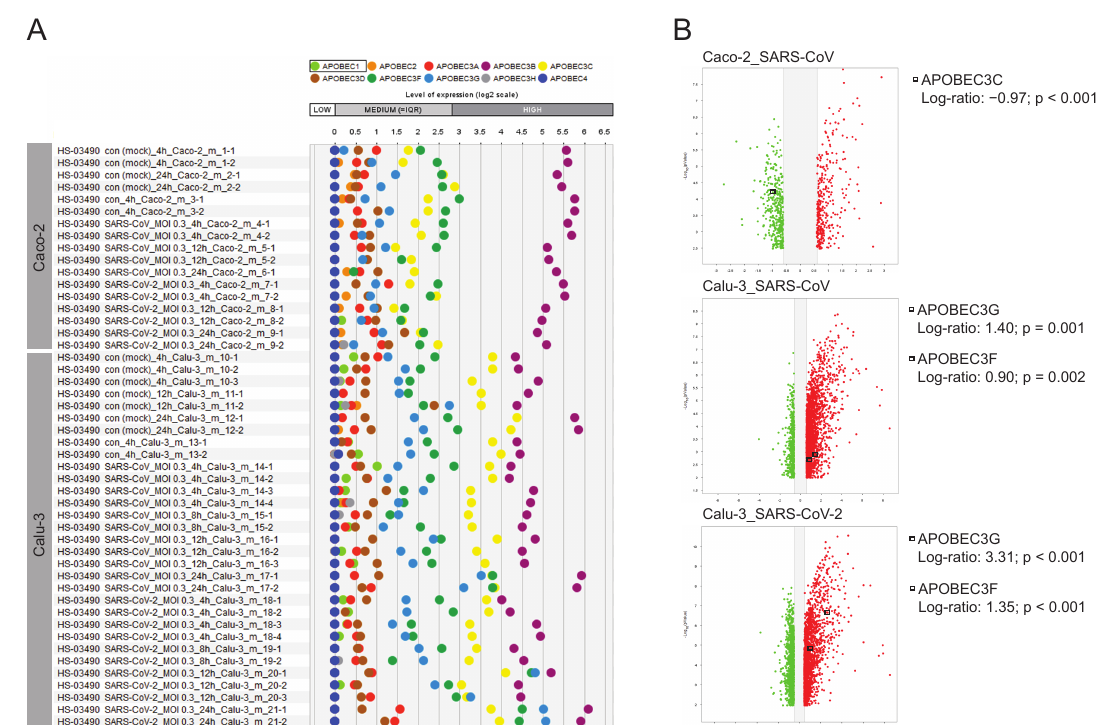
Figure 7. Expression map of APOBECs in Caco-2 cells and Calu-3 cells and their regulation on the transcriptional level upon infection with SARS-CoV-2 or SARS-CoV. Here the GENEVESTIGATOR- based analysis strategy is applied with the focus given to a particular gene set, the APOBECs. ( A ) The expression pattern of 10 APOBECs across the individual conditions is shown by scatterplots on the basis of GENEVESTIGATOR analysis of the mRNAseq dataset GSE148729 across Caco-2 and Calu-3 cells. The levels of expression of mock-infected cells and those infected with SARS-CoV or SARS- CoV-2 viruses are shown (various time points upon infection are given as log2 transformed values, sub-divided into low, medium, and high expression according to GENEVESTIGATOR). ( B ) Volcano plots illustrate the differentially expressed genes for a given condition; only conditions where APOBEC(s) were found among the differentially expressed genes are indicated. Squares indicate the position of the corresponding APOBEC; the Log-ratios and p -values are given. GENEVESTIGATOR- based analyses were performed, and the corresponding data were extracted in September 2020 and March